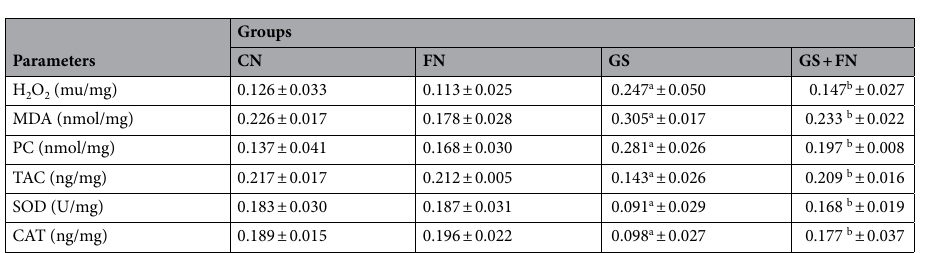
Table 1. Oxidative stress markers and antioxidants in the lung of the investigated groups. Data are presented as means ± SD. CN control, FN Fenugreek diet, GS gasoline. a,b Superscripts refer to significant changes ( p < 0.05). a All groups compared to the CN group. b GS + FN group compared to the GS group.